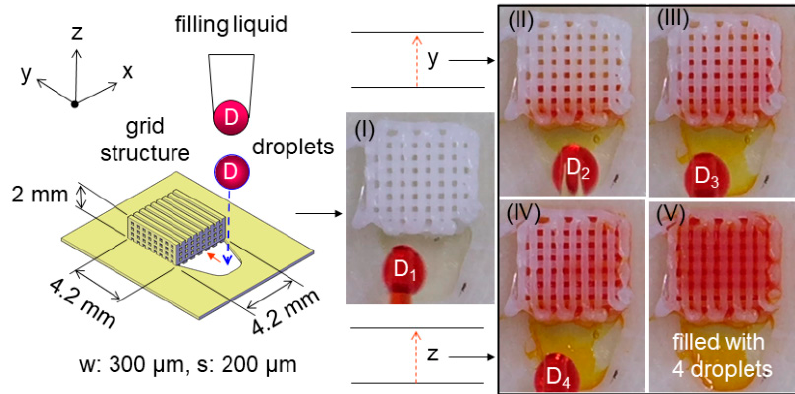
Figure 8. Demonstration of capillary liquid supply into a 3D printed grid structure (4.2 mm × 4.2 mm × 2 mm) from each droplet of 2.5–3.5 μ L generated by a pipette: ( I )–( IV ) consecutive droplets from the first D 1 to the fourth D 4 and ( V ) filled with the 4 droplets of 10–14 μ L in total.